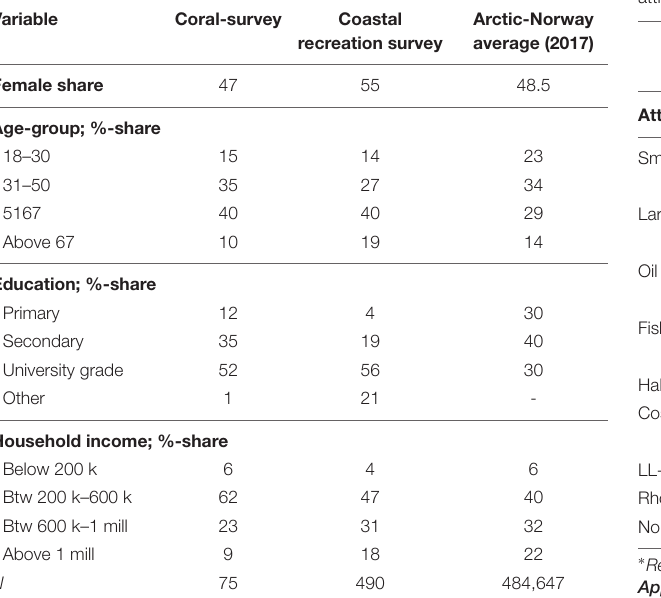
TABLE 3 | Socio-demographic characteristics. TABLE 4 | Average preference sensitivities for economic vs. environmental attributes across two surveys.